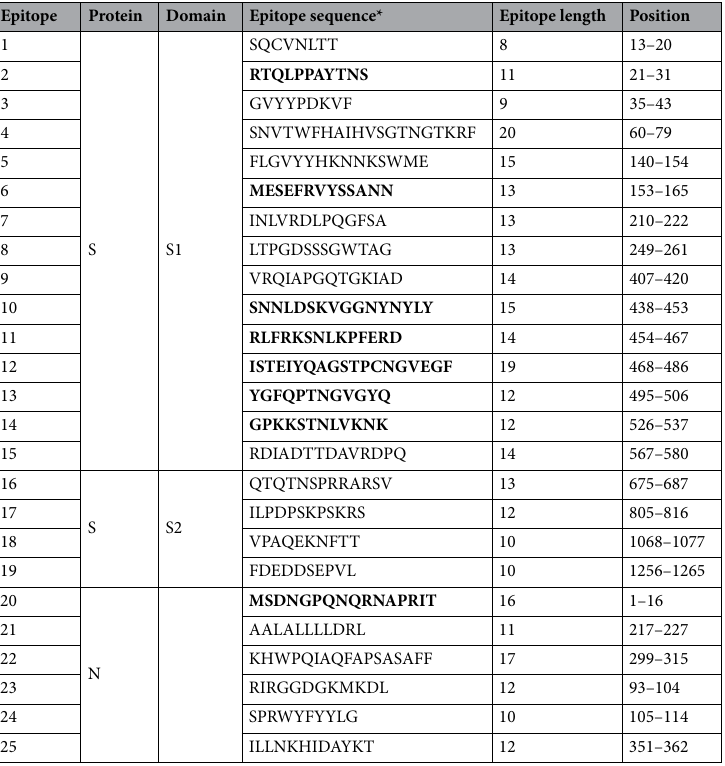
tion (Table 1). For the third round of selection, only S1 (without subclassifications) and S2 domains were used considering immunogenicity, antigenicity, and the type of epitope (linear or conformational) for the selection of fifteen peptides in S1, four peptides in S2 and six peptides in N (Table 2).